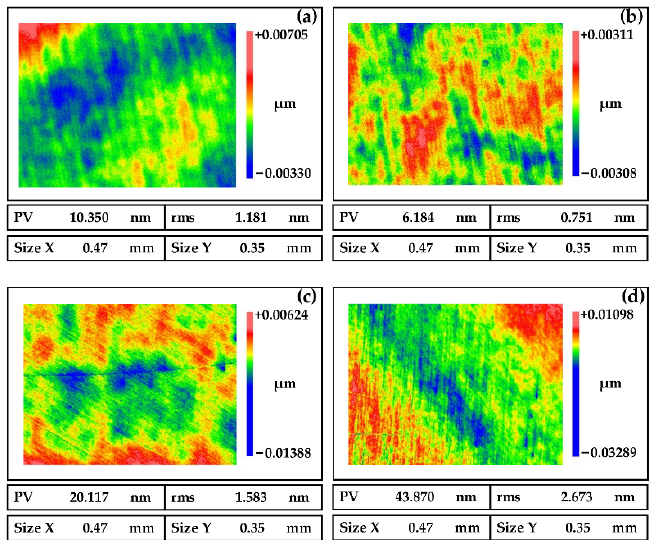
Figure 9. Polished surfaces of NiP coating induced by different speeds ( a ) 50 rpm, ( b ) 100 rpm, ( c ) 150 rpm, and ( d ) 200 rpm.